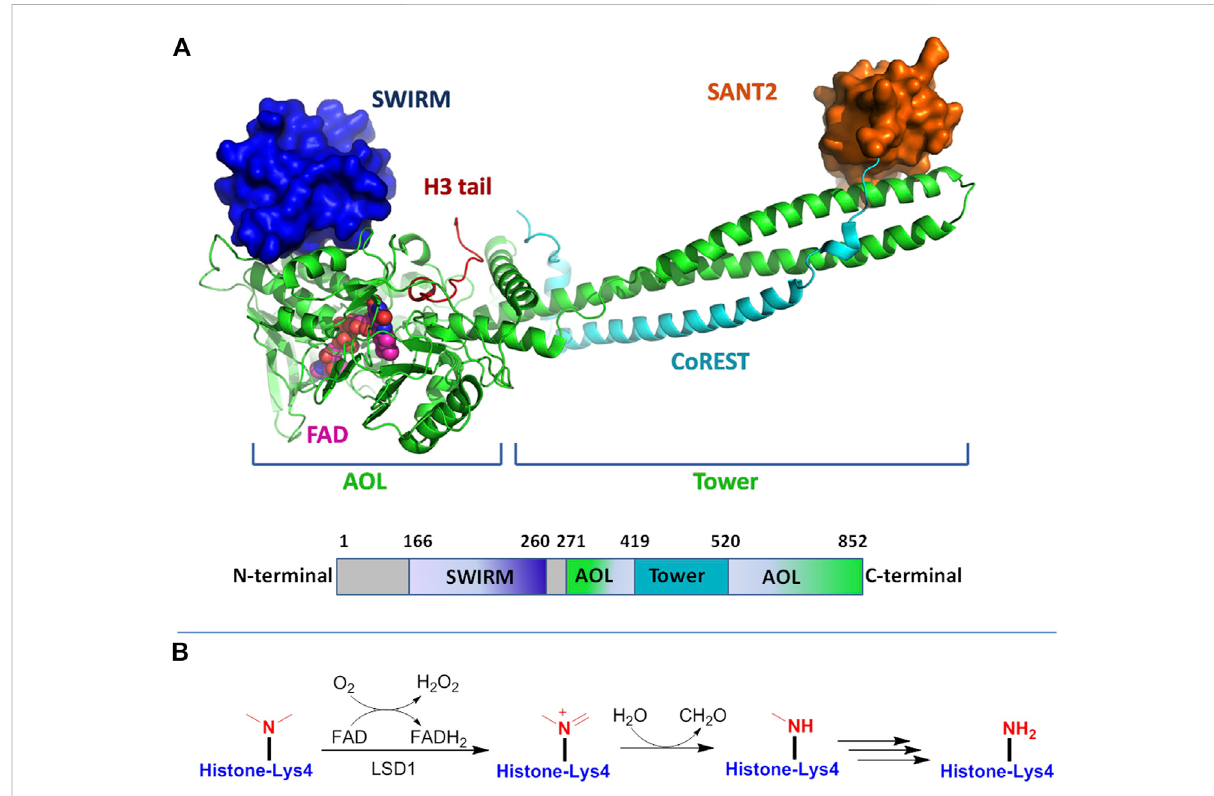
FIGURE 2 (A) Structure of LSD1 protein: up for the 3D model and down for the schematic illustration of LSD1 domains. Figures were created using PyMol (http://pymol.sourceforge.net); (B) FAD-dependent demethylation mechanism of mono-methylated lysine residue by